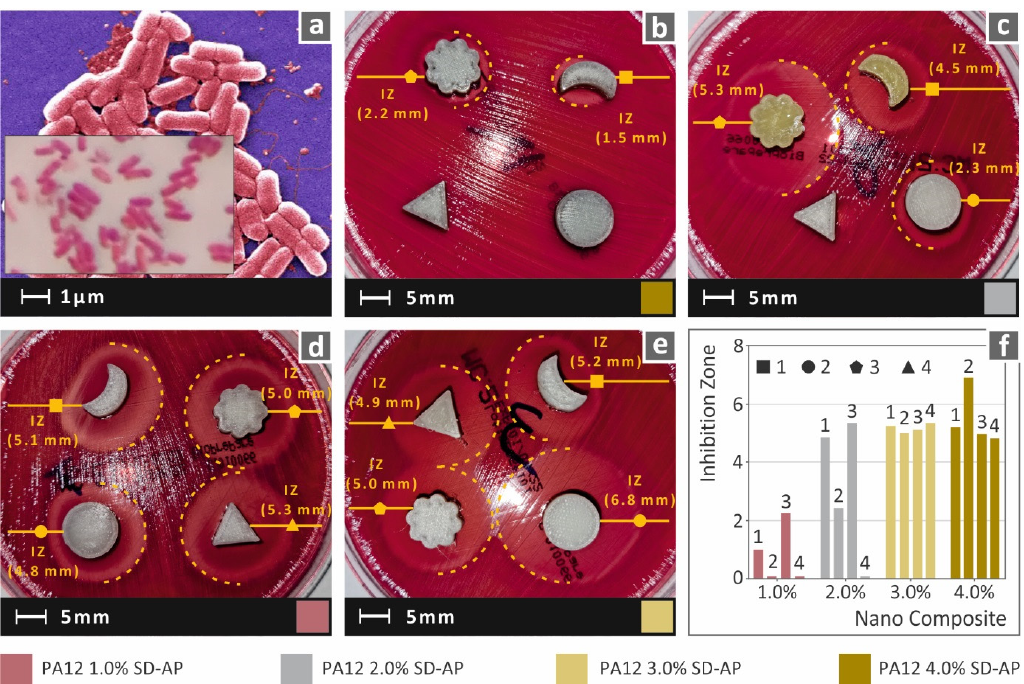
Figure 13. ( a ) Typical E. coli morphology; ( b – e ) lateral captures of Petri dishes and the corresponding inhibition zones measurements of the corresponding nanocomposites; ( f ) comparison of inhibition zone measurements among the different specimen shapes and nanocomposites studied. Polymers 2022 , 14 , x FOR PEER REVIEW